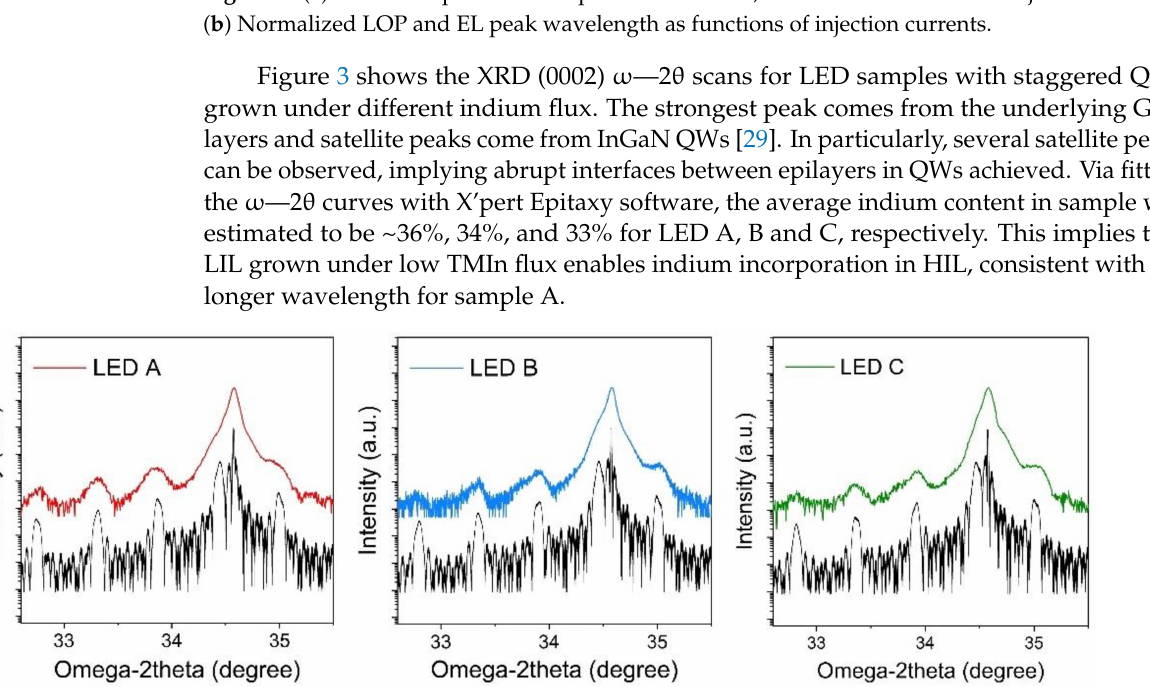
Figure 3. XRD (0002) ω -2 θ scan curves for LEDs A, B and C. Black lines represent the fitting